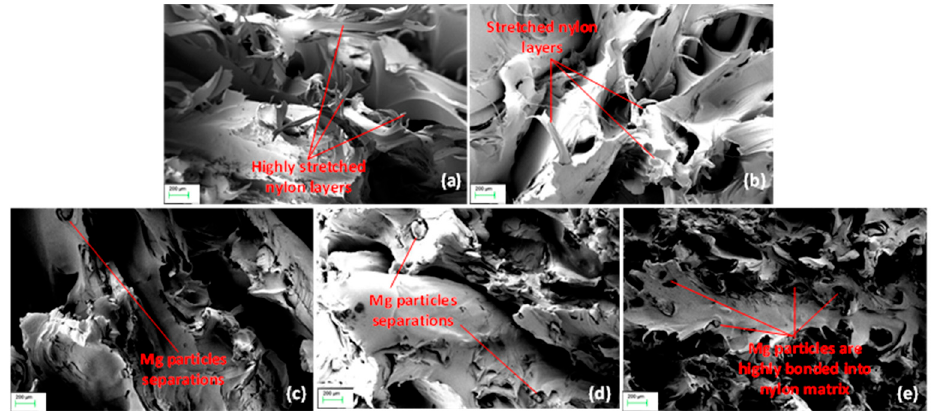
Figure 6. SEM imaging of tensile failure zones for: ( a ) OTS; ( b ) waste; ( c ) 2% Mg; ( d ) 4% Mg;